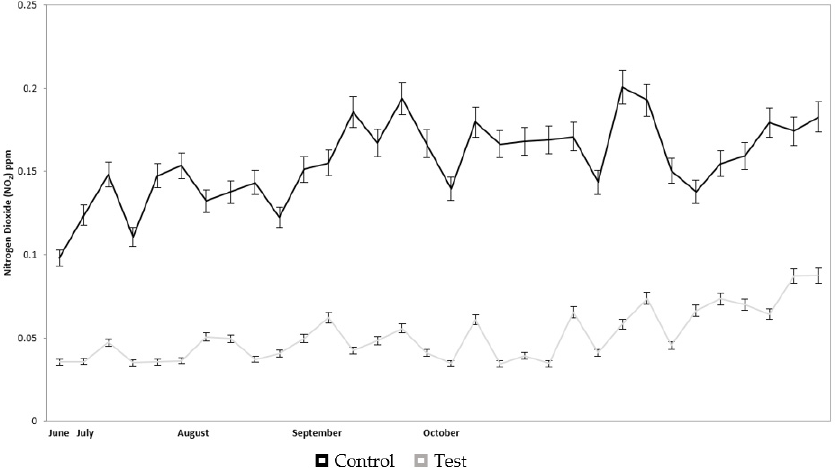
Figure 8. Daily average nitrogen dioxide (ppm) for test and control across all sites, June to October